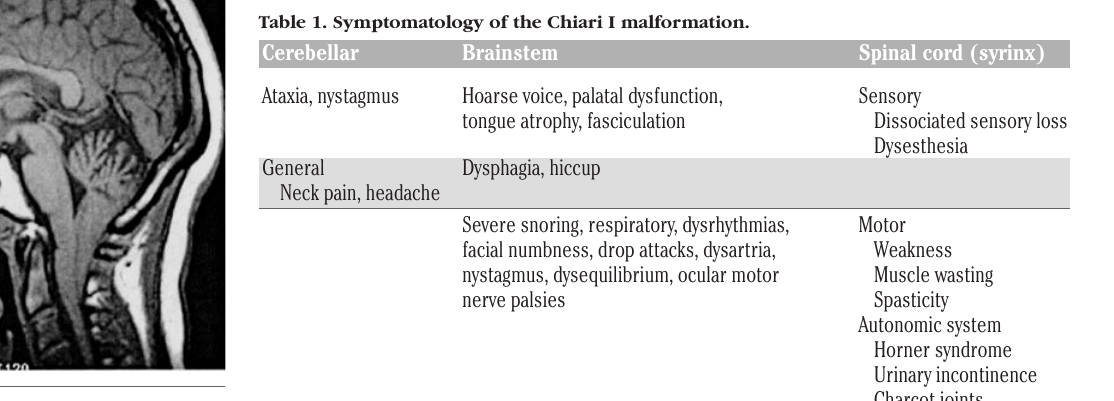
Figure 1. Sagittal view showing 15 mm her- niation of the cerebellar tonsils consistent with diagnosis of Chiari I